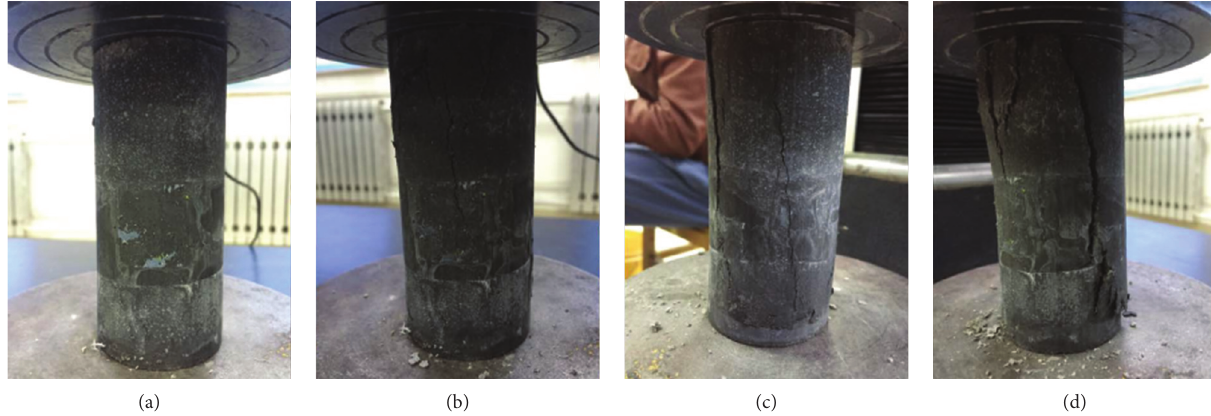
Figure 5: Global destruction pattern of the grouted body (W/C � 0.8). (a) Initial state. (b) Fracture occurrence. (c) Fracture development. (d) Destruction.